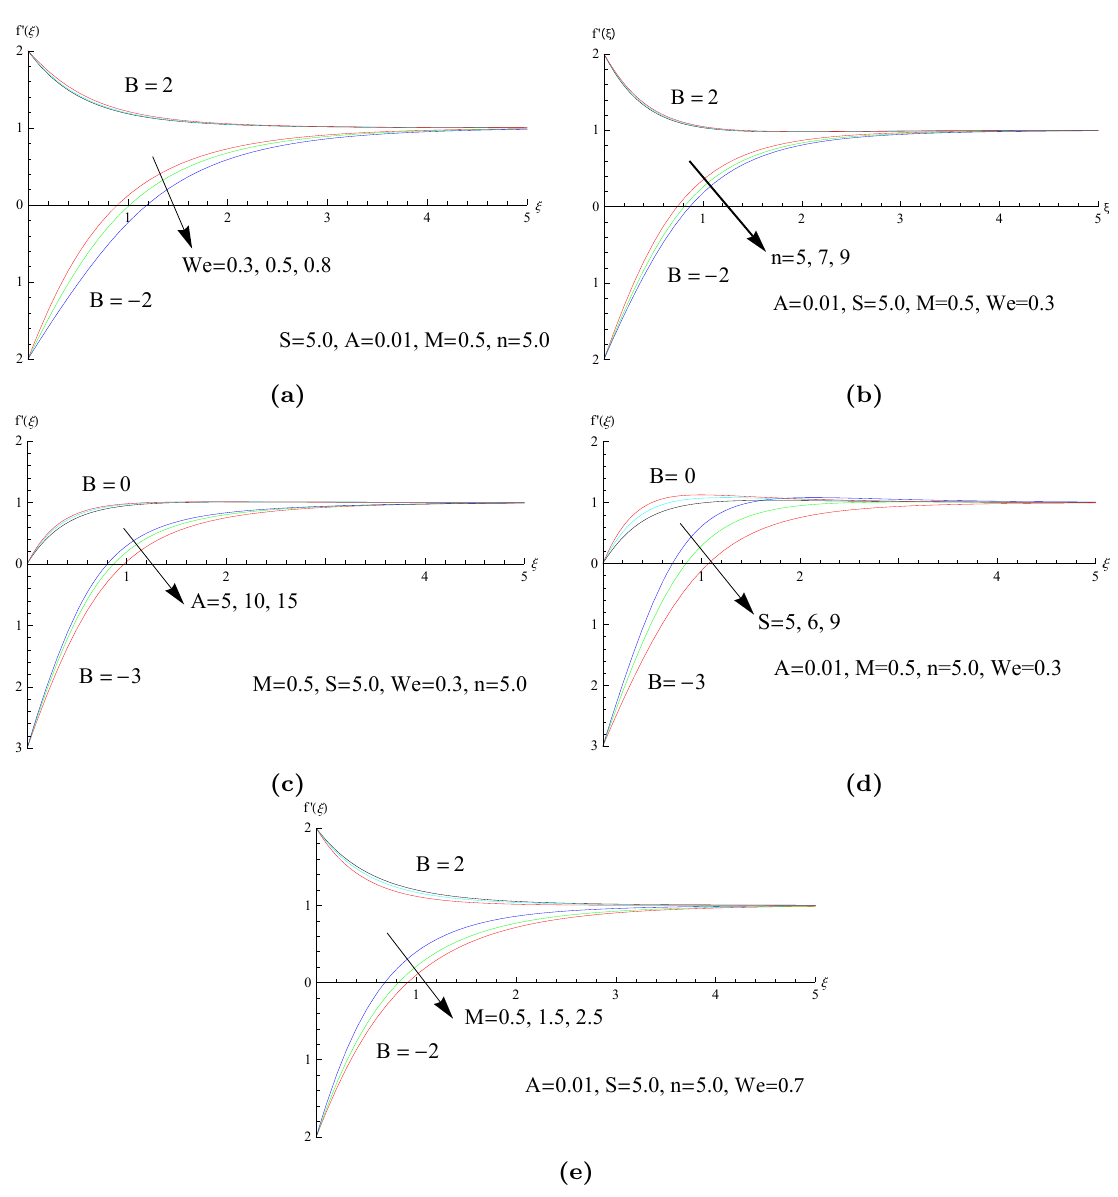
Figure 2: Behavior of velocity profile against pertinent fluid parameters. ( a ) variation of We; ( b ) vari-